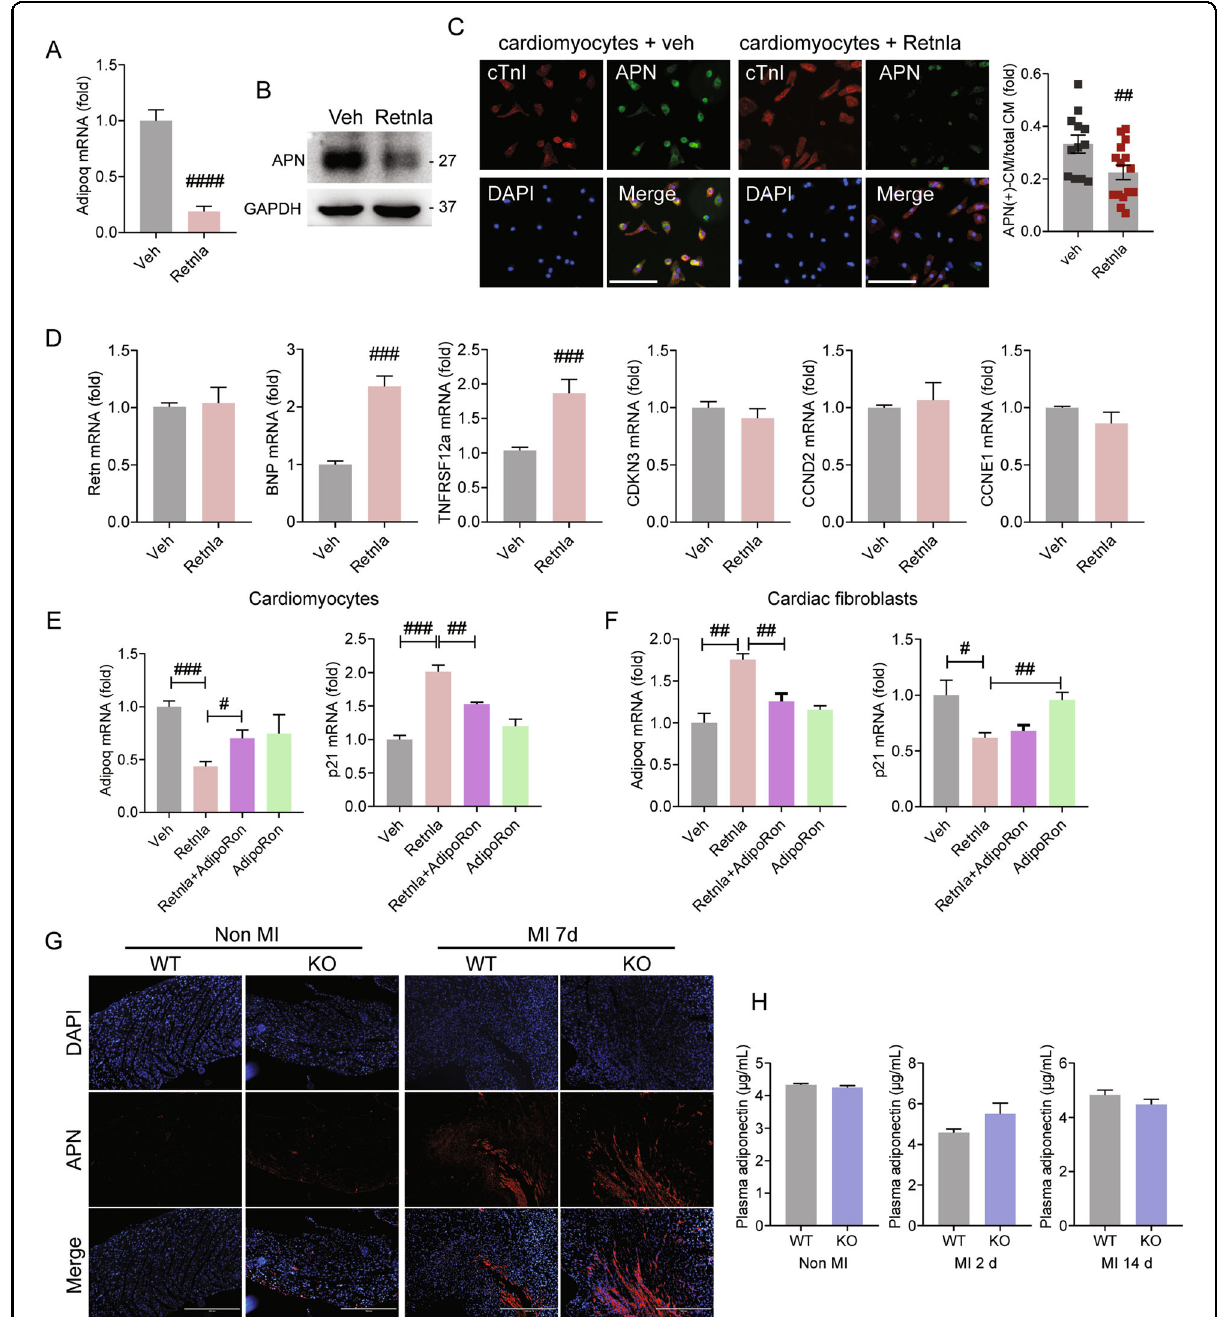
Fig. 4 Involvement of adiponectin in cardiac protection mediated by unsorted bone marrow cells. A The mRNA level of adiponectin (Adipoq) was assessed in neonatal rat cardiomyocytes treated with vehicle (veh) or Retnla (500 ng/mL) for 24 h. B Adiponectin (APN) protein expression was determined by western blot in neonatal rat cardiomyocytes. C Endogenous APN expression was assessed by immuno fl uorescence staining in neonatal rat cardiomyocytes treated with veh ( n = 12) or Retnla (500 ng/mL, n = 15). Adiponectin-expressing cardiomyocytes were counted and quanti fi ed. Scale bars, 200 μ m. D Relative gene expression analysis of resistin (Retn), brain natriuretic peptide (BNP), tumor necrosis factor receptor superfamily member 12a (TNFRSF12A), cyclin-dependent kinase inhibitor 3 (CDKN3), cyclin D2 (CCND2), and cyclin E1 (CCNE1) in cardiomyocytes treated with veh or Retnla (500 ng/mL) for 24 h. E , F AdipoRon, adiponectin receptor agonist that binds adiponectin receptor 1 and 2, partially restored the transcriptional levels of adiponectin and p21 in Retnla-treated cardiomyocytes and cardiac fi broblasts. G APN protein expression was determined in the myocardium. Scale bar, 400 μ m. H Circulating level of APN was measured in WT mice ( n = 8) and KO mice ( n = 8) at 0 day, 2 days, and 14 days after MI. Data are represented as mean ± SEM. # P < 0.05, ## P < 0.01, ### P < 0.001 (by Student ’ s t test or one-way ANOVA with Bonferroni ’ s multiple comparisons test).